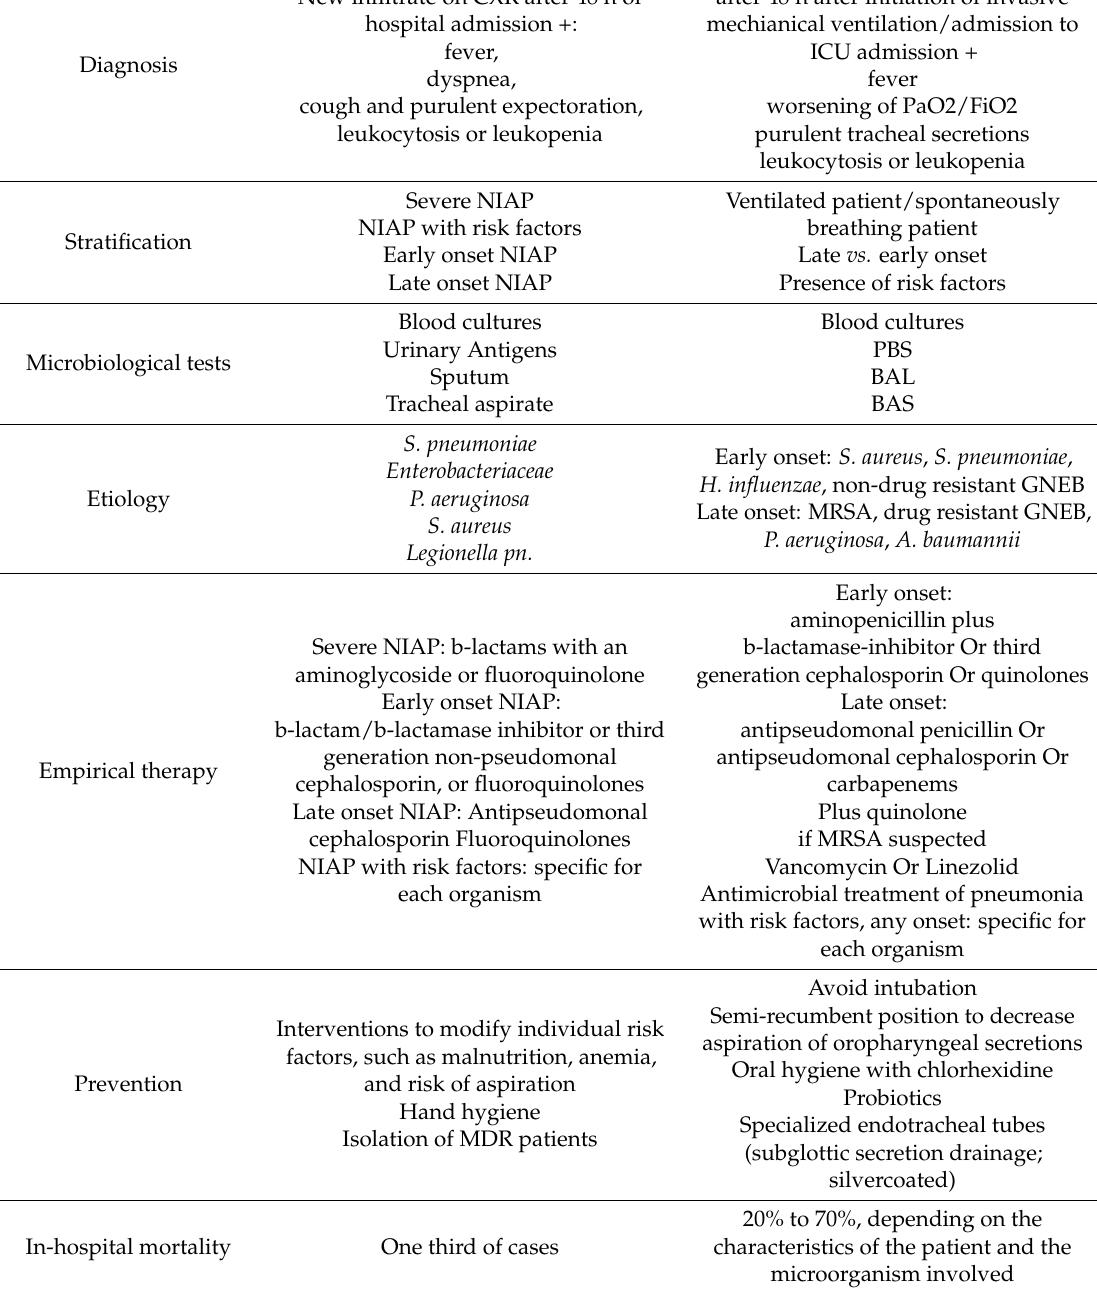
Table legend: NIAP non ICU-acquired pneumonia, VAP ventilator associated pneumonia, NV-ICUAP non ventilator ICU acquired pneumonia, CXR chest X ray, ICU intensive care unit, PBS protected specimen brush, BAL bronchoalveolar lavage, BAS bronchial aspirate, GNEB gram negative Enteric Bacilli, MRSA methicillin resistant S. aureus